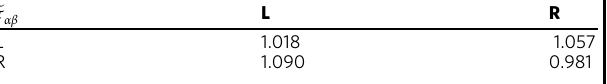
Table 2 Normalised class mean fi rst massage times (CMFPT) between constituencies that voted for Leave (L) or Remain (R) in the Brexit referendum if we consider the ensemble of colour assignments where a node is assigned to Leave (Remain) with a probability equal to the fraction of voters supporting Leave (Remain) in that